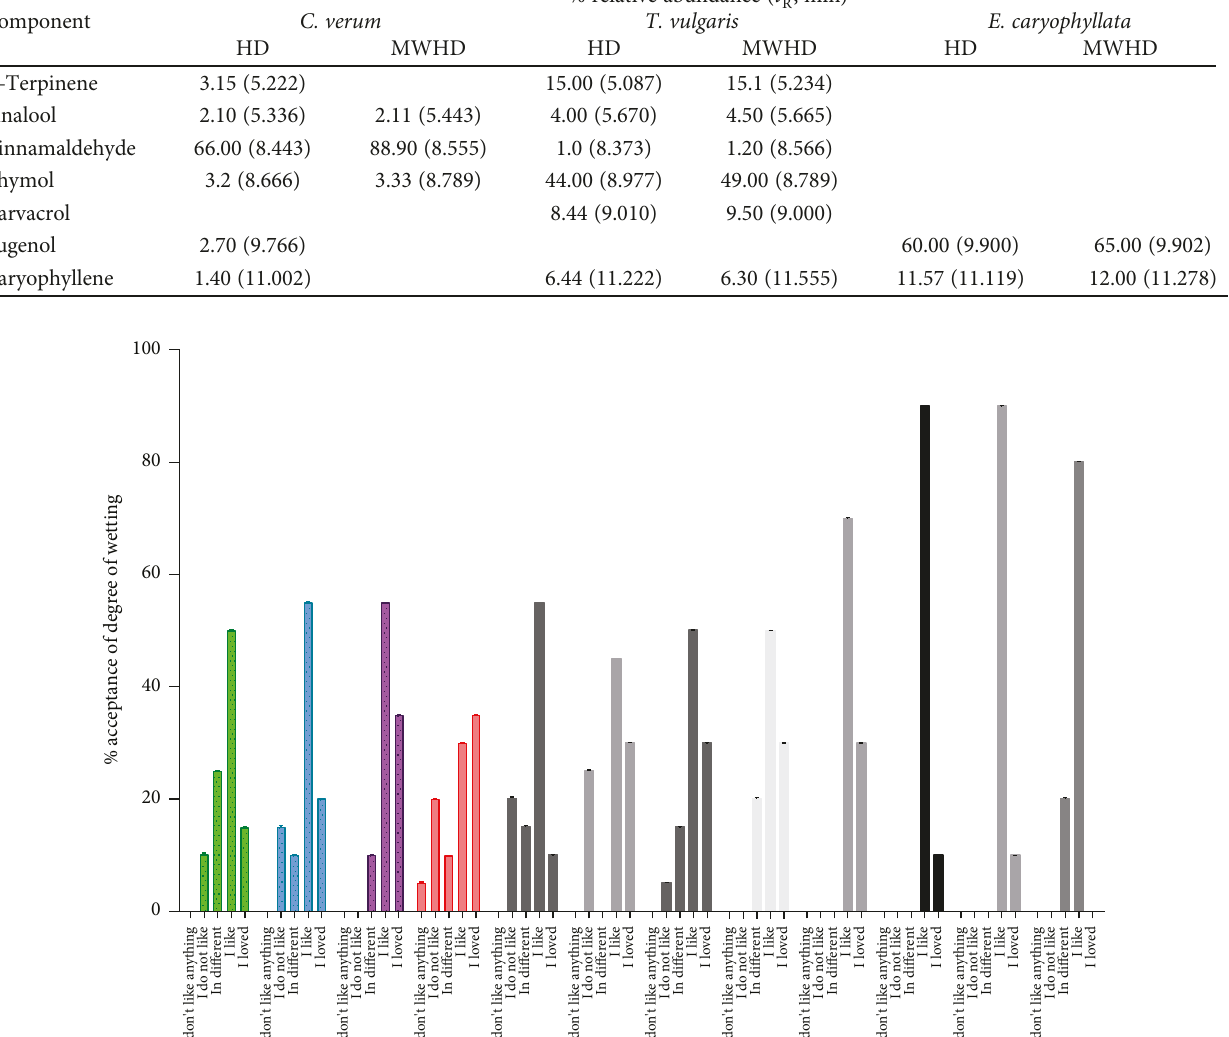
Table 5: Major components detected in EO microcapsules obtained by HD and MWHD after 15 days of exposure to air. Component